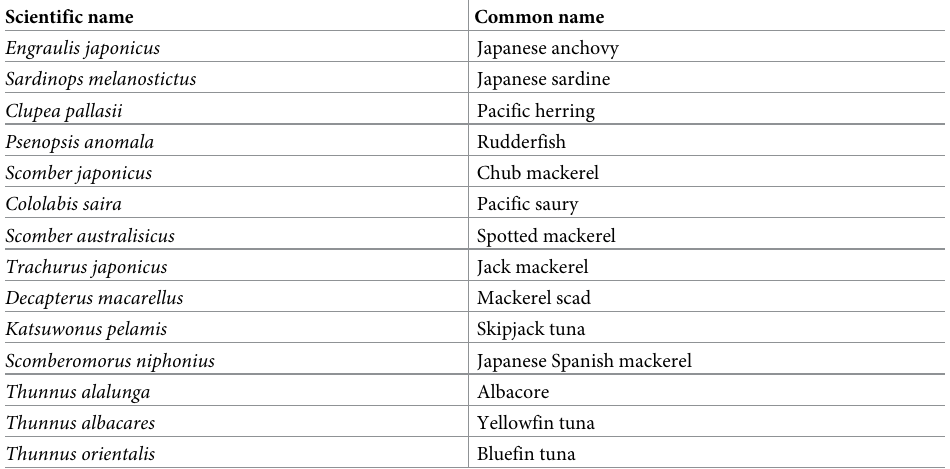
Table 1. List of the 14 pelagic fish species considered in this study. Scientific